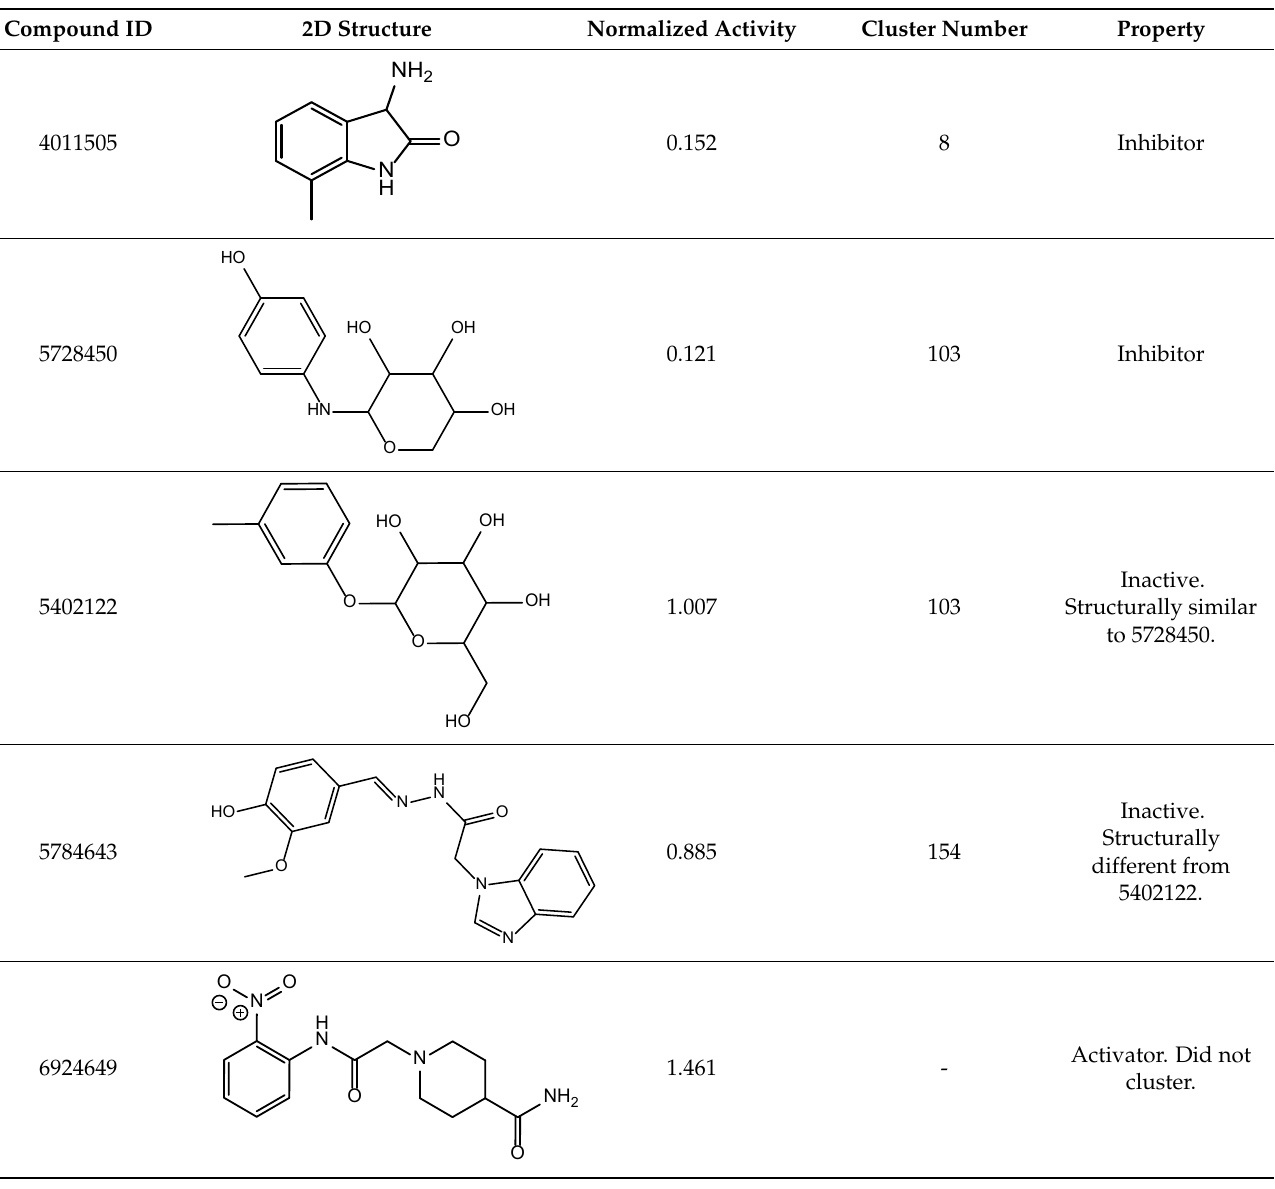
Table 3. Representative variability of compound structures, as obtained by cluster analysis using Data Warrior [25]. Activity values calculated from experiments in Echelon enzymatic assay.